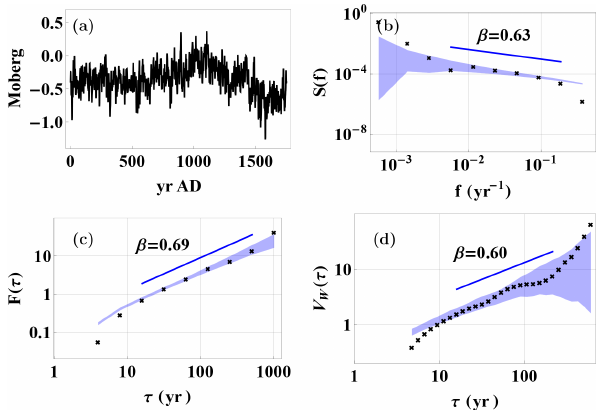
Figure 2. (a) The Moberg reconstructed temperature. (b) PSD, (c) DFA2, and (d) WVA2 applied to the record. The shaded areas are the 95% confidence range for synthetic fGn with β estimated by PSD, DFA2 and WVA2. The β -values are estimated from the slopes of the straight lines and the range of scales used for estimation is indicated by the length and position of these line segments. The estimated β -values are indicated in the